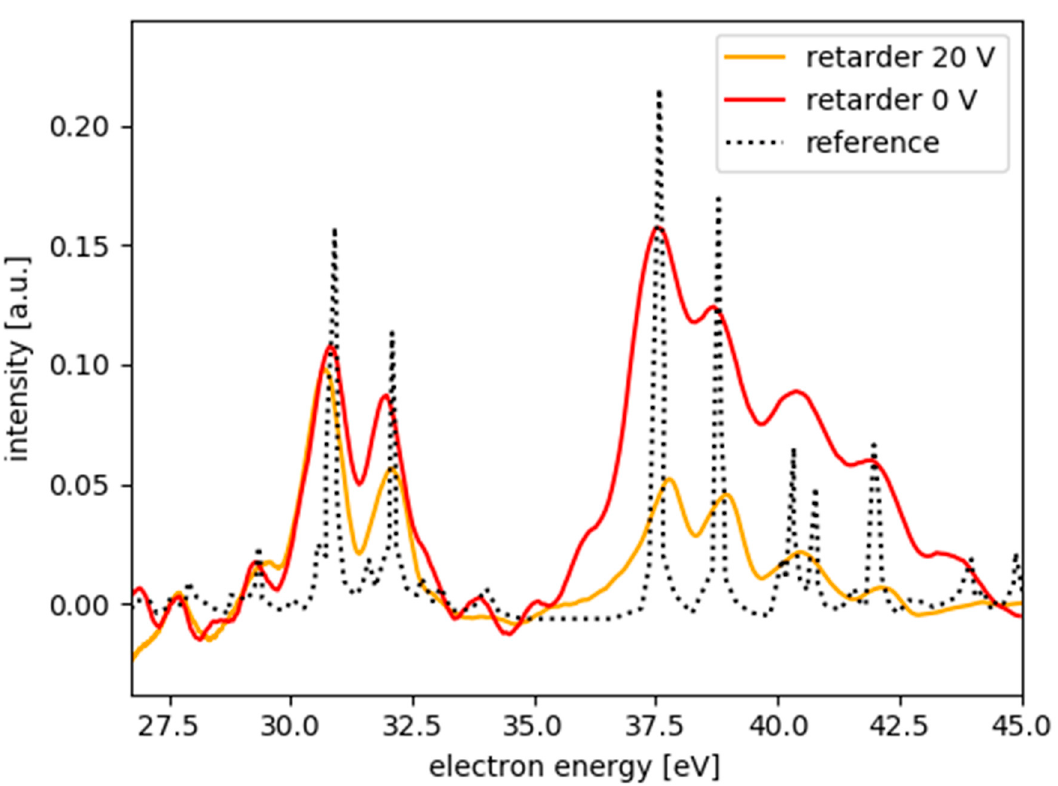
Figure 4. Krypton M 4,5 NN Auger spectra recorded with the URSA-PQ instrument using 270 eV photons (red spectrum using a retardation of 0 V, orange spectrum using a retardation of 20 V). The spectra are recorded with a back-filled interaction chamber and converted from time-of-flight (TOF) to kinetic energy. The black spectrum from Reference [29] serves as a reference.